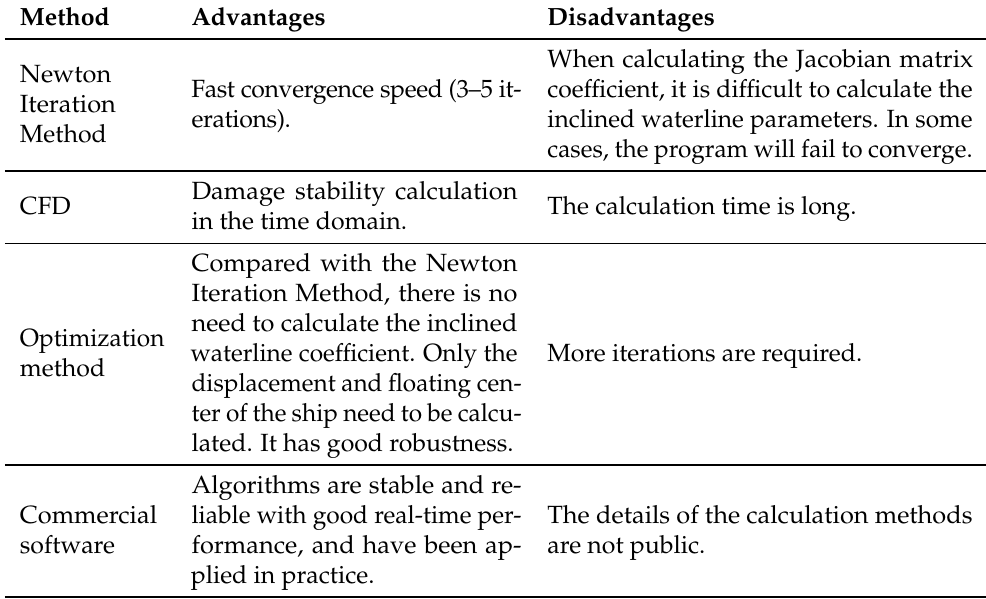
Table 2. Advantages and disadvantages of current research methods.